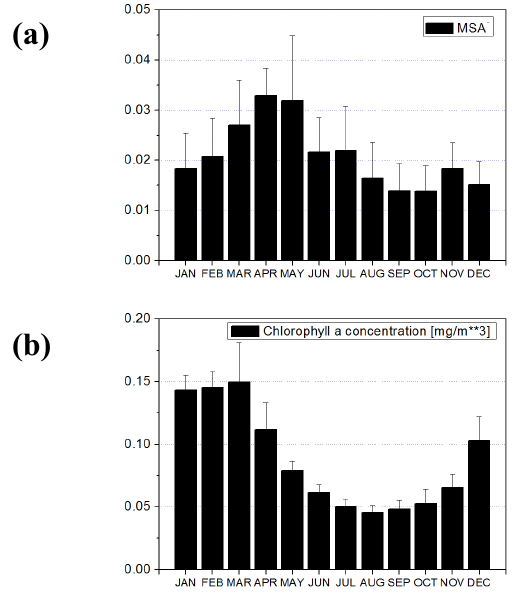
Figure 11. Monthly mean variation of (a) MSA − (µgm − 3 ) and (b) chlorophyll a concentrations for the study period. Chlorophyll a concentrations were downloaded from the MODIS Aqua satellite over the region 140–145 ◦ E, 25–30 ◦ N for the study period. Figure 12. (a) The SeaWiFS images that captured the large Asian dust storm visible over the Sea of Japan and North Pacific during 17 March–2 April 2002. (b) Temporal variations of MSA − and nss- Ca 2 + concentrations during 2002 over the western North Pacific. The black regions in (a) are the gaps between consecutive SeaWiFS viewing swaths and represent areas where no data were